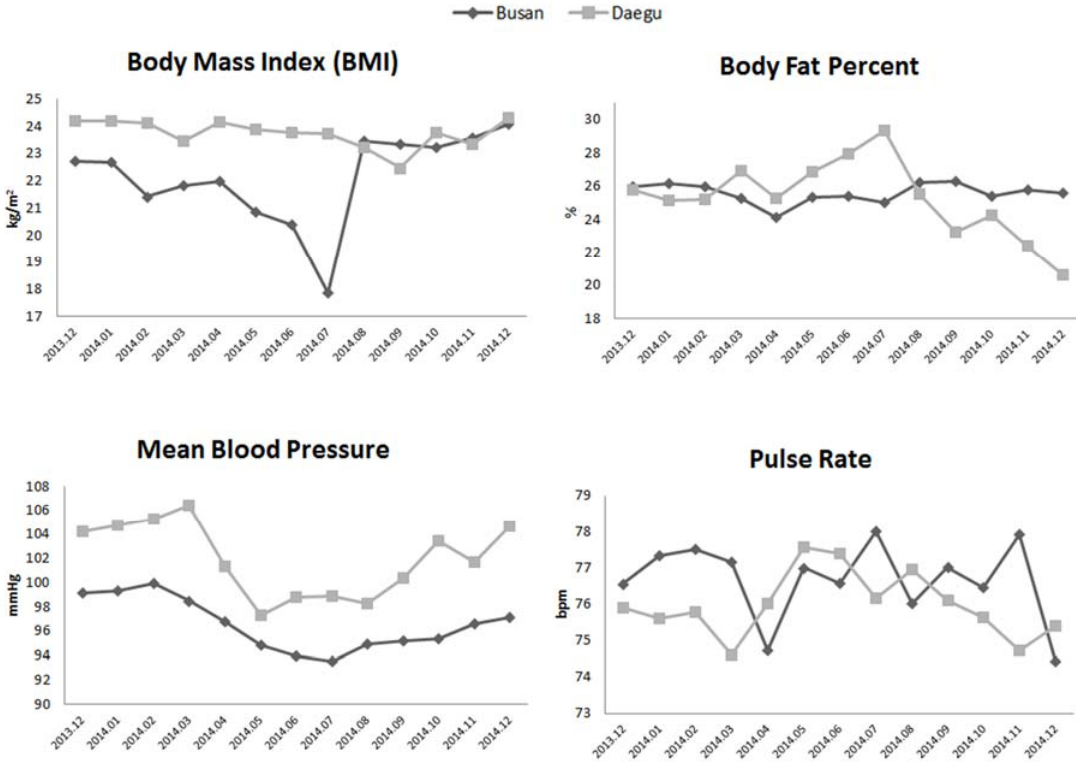
Figure 3. Monthly trends of health test readings.